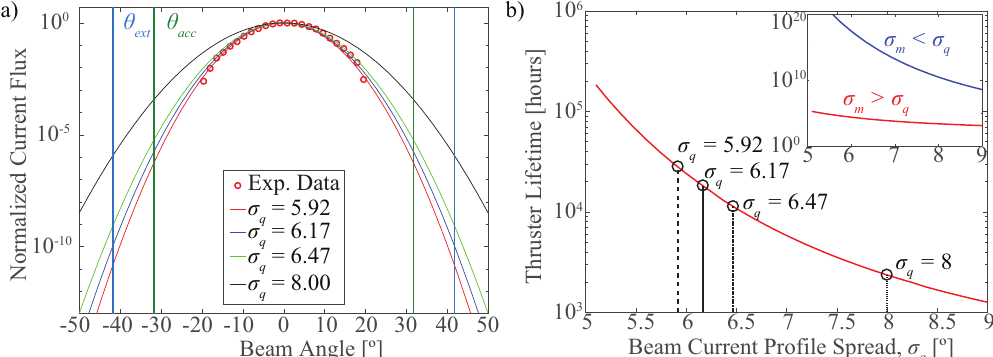
Figure 6. ( a ) A range of Gaussian fits to CMNT current profile data assuming 7.5% full-scale error and a normal fit indicating a current profile outside full-scale error but within uncertainty in the high-angle region. θ acc in the given case is 32 ◦ . ( b ) Life model predictions for thruster lifetime as a function of current profile standard deviation with data fits from ( a ) indicated. The inset shows the lifetime calculations for both values of σ m that satisfy Equation